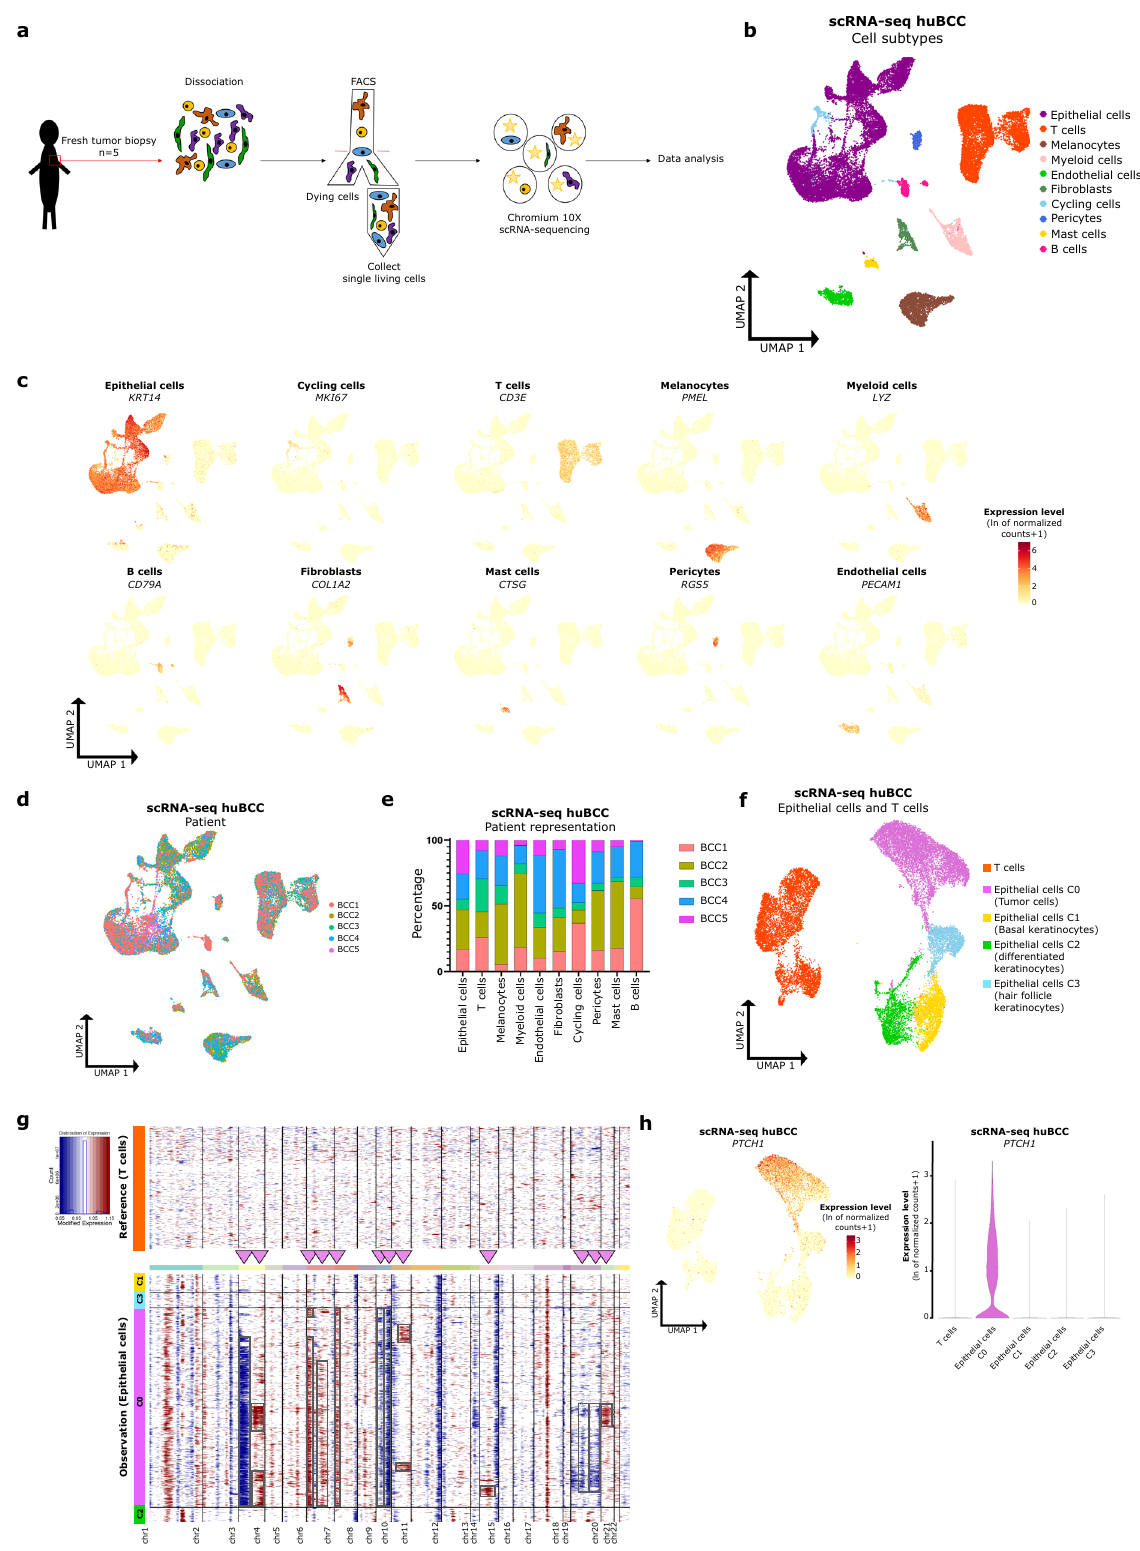
fi ltered signatures (Supplementary Fig. 4c; Supplementary Data 3): a spatialTumorDEGsignature(57genes)composedofanodular(spatial T NOD ,45genes)andanin fi ltrative(spatialT INF , 12genes)signatures;and a spatial Stroma DEG signature (46 genes) composed of a nodular (spatial S NOD , 3 genes) and an in fi ltrative (spatial S INF , 43 genes) sig- natures. As expected, the spatialTumor DEG signaturewasenriched in